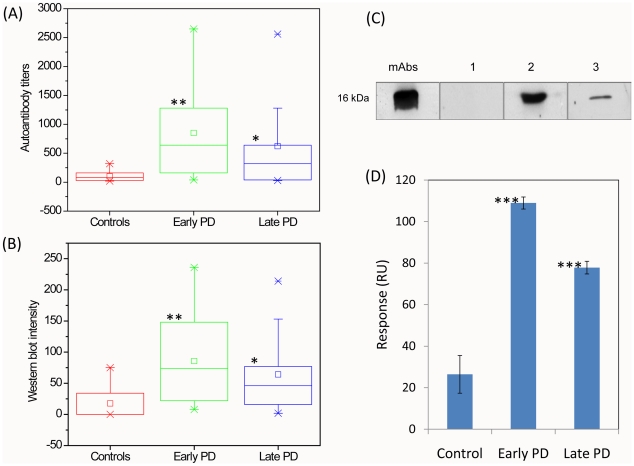
Immune responses towards α-synuclein monomer in the blood sera of controls, early and late PD patients.Box-plots showing statistical distributions of immune responses to α-synuclein measured by ELISA (A) and Western blotting (B). The antibody titers (A) and Western blot band densities (B) are shown along y-axis and the groups subjected to analysis - along x-axis. Boxes include from 25% to 75% of all immune responses; central squares indicate the mean and line drawn crossed the box – the median values for each group; whiskers indicate the distribution from 5% to 95%, while small crosses correspond to remaining 10%. (C) Representative Western blots showing interactions with monomeric α-synuclein of monoclonal antibodies (mAbs) and sera IgGs from selected control (1), early PD (2) and late PD (3) individuals. (D) Biacore analysis of the interactions with α-synuclein of pooled IgGs from controls, early and late PD patients. Surface plasmon resonance responses in relative units are shown in y-axis. ***P<0.0001, **P<0.007 and *P<0.05.